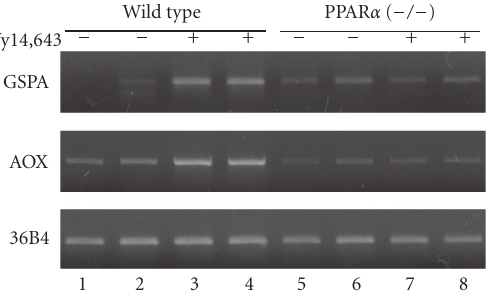
Figure 2: GSPA is a target gene of PPAR α . RT-PCR was performed with RNA samples from two animals for wild type or PPAR α -null mice treated or not with Wy14,643. A ribosomal subunit gene, 36B4, was used as a control una ff ected by Wy14,643. PCR was per- formed for 30, 22, and 26 cycles for GSPA, AOX, and 36B4, respec- tively. Other experimental conditions were as described in